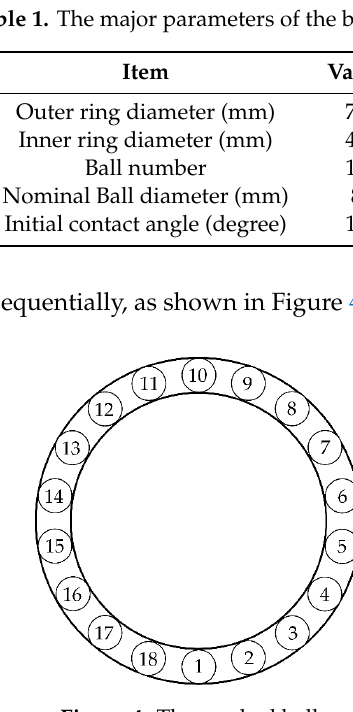
Figure 4. The marked balls.